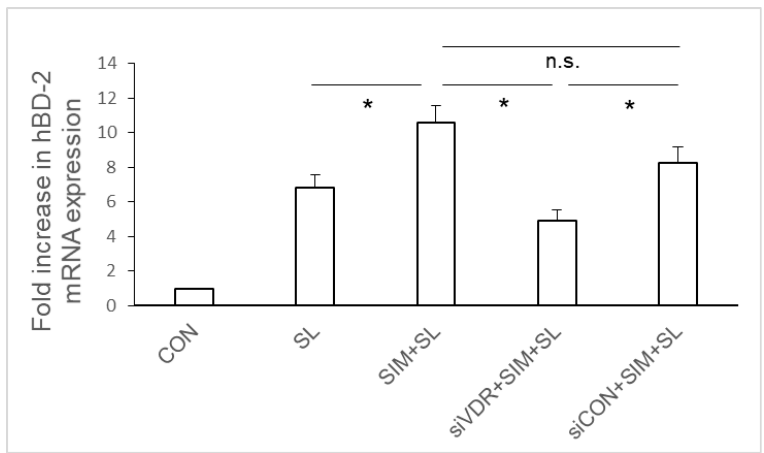
Figure 6. Involvement of VDR in simvastatin-mediated enhanced hBD-2 mRNA expression in Salmonella -infected SW480 cells. SW480 cells were transfected with control or VDR siRNA (siCON = non-target control siRNA; siVDR = siRNA against VDR) for 48 h. Transfected SW480 cells were untreated or treated with 10 μM simvastatin (SIM) prior to wild-type S. Typhimurium strain SL1344 infection (SL) for one hour. Total RNA was prepared after infection and analyzed by real-time quantitative PCR to estimate the levels of hBD-2 mRNA. The amount of hBD-2 mRNA produced, normalized to the corresponding amount of GAPDH mRNA, is shown as the fold increase over uninfected, control (CON) cells. The results indicate the means and standard deviations for duplicate wells from at least three separate experiments (* p < 0.05).